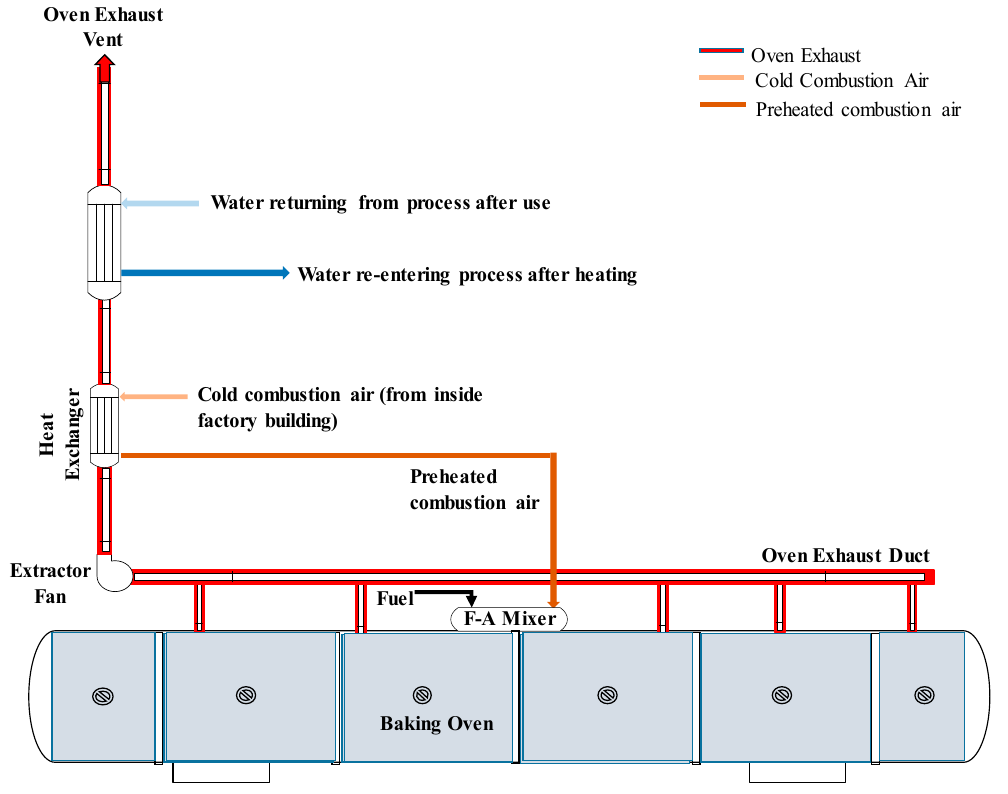
Figure 9. Schematic of combustion air preheating combined with reheating process water using oven exhaust gases.